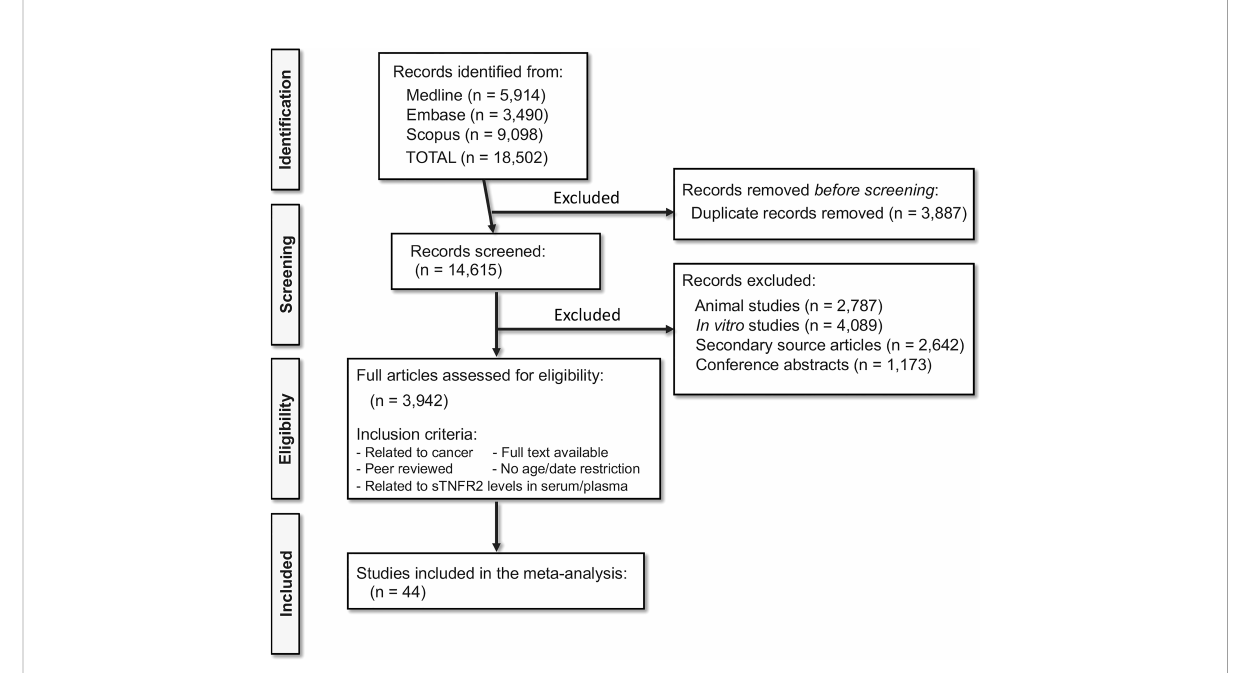
FIGURE 1 Selection of studies following PRISMA fl owchart. Medline, Embase, and Scopus database searches resulted in the identi fi cation of 18,502 relevant articles. Following the exclusion and inclusion criteria, 44 articles were selected for the